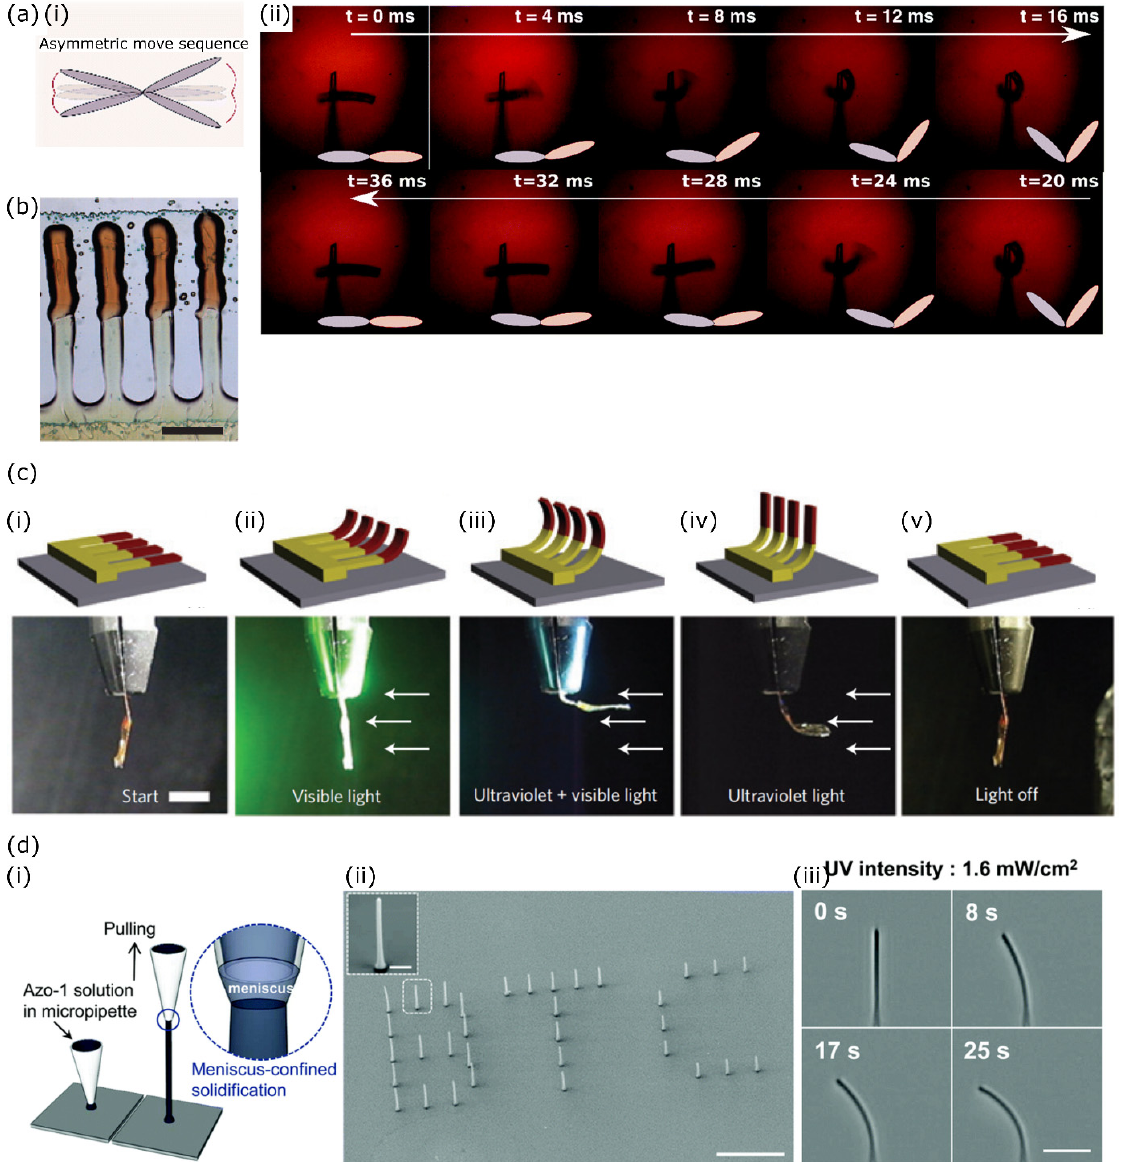
Figure 6. Responsive liquid crystal microstructures obtained through additive manufacturing tech- niques. ( ai ). Schematic illustration of the composite microactuator obtained through 2PP combined with DLW. ( aii ). Frames obtained from a high-speed video of the composite microactuator bending asymmetrically in response to a homogeneous stimulus. Adapted under the terms of the CC BY Creative Commons Attribution 3.0 Unported license [55]. Copyright 2017, The Royal Society of Chemistry. ( b ) Inkjet-printed artificial composite cilia and ( c ) their actuation sequence. The cilia at rest ( i ) are illuminated with visible light to address one azobenzene derivative ( ii ), adding UV light addresses both azobenzene derivatives ( iii ). Removing the visible light allows one azobenzene de- rivative to relax ( iv ). The cilia return to their rest state when all light is switched off ( v ). The scale bar of b is 0.5 mm and the one of c 5 mm. b and c are adapted from ref [28]. Copyright 2009, Nature Publishing Group. ( di ). Schematic of the 3D deposition technique used to fabricate self-assembled light-responsive fibres. ( dii ). SEM micrograph of fibre arrays where the three letters consist of fibres of different lengths (L to R: 20, 15, 10 µm), demonstrating the controllability and versatility of the approach. ( diii ). Optical micrographs of a UV-illuminated fibre over time. The UV light is incident from the left. Adapted under the terms of the CC BY-NC Creative Commons Attribution-NonCom- mercial 3.0 Unported license [56]. Copyright 2015, The Royal Society of Chemistry.